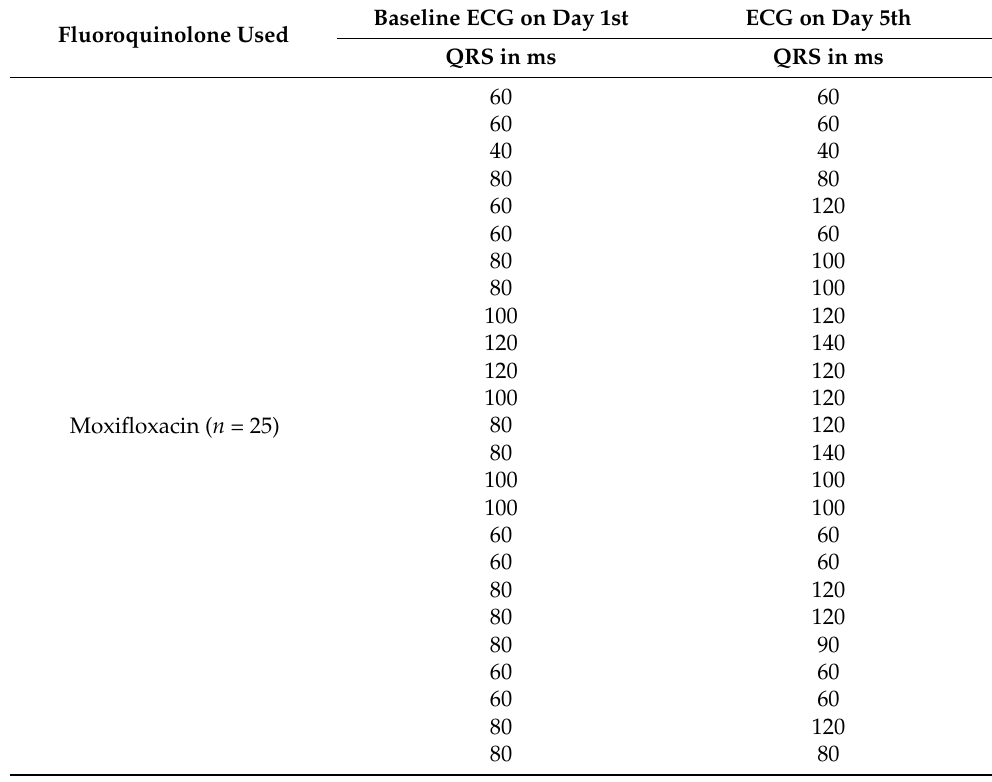
Table 7. Baseline QRS (ms) complex and QRS (ms) complex on day five in the Moxifloxacin group. Fluoroquinolone Used